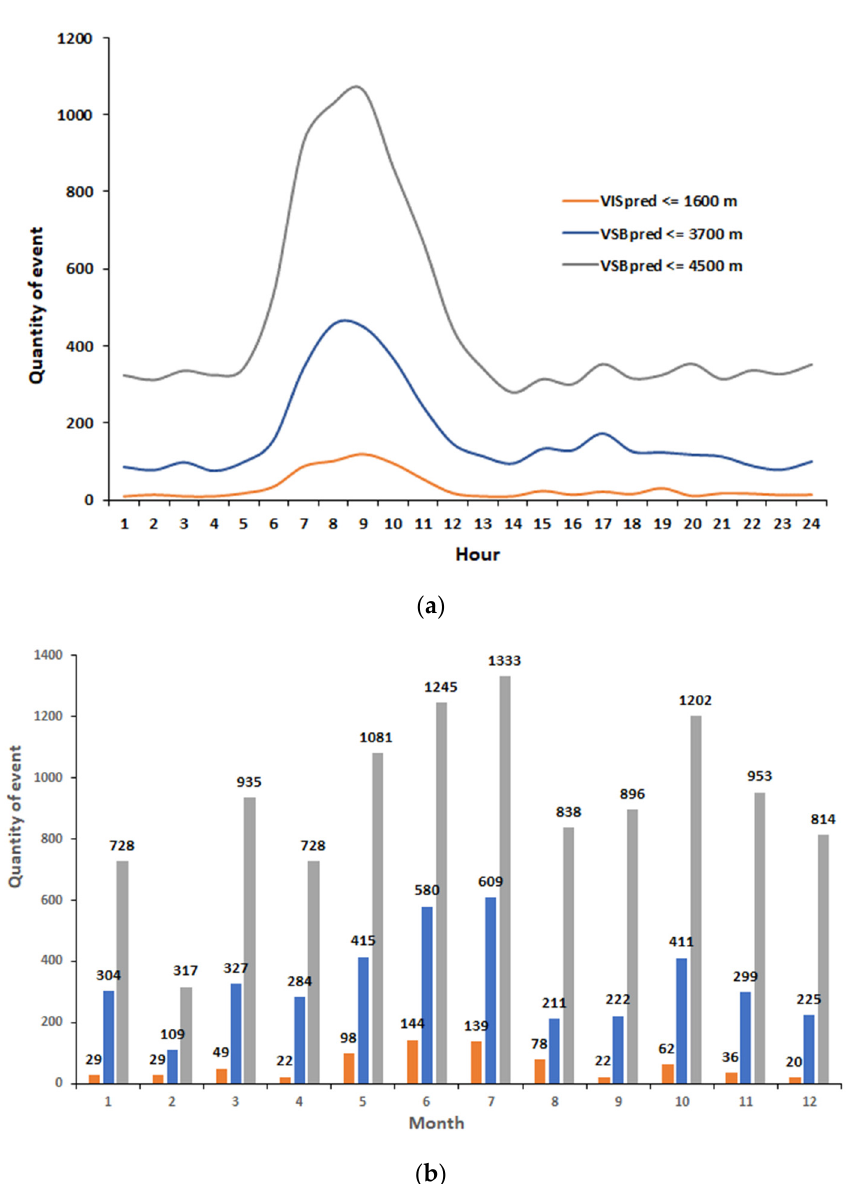
Figure 2. Representation of the hourly ( a ) and monthly ( b ) distribution of 15 min meteorological records where visibility was below or equal to the limits of 4500 (bars and lines in gray), 3700 (bars and lines in blue), and 1600 (bars and lines in orange) meters,